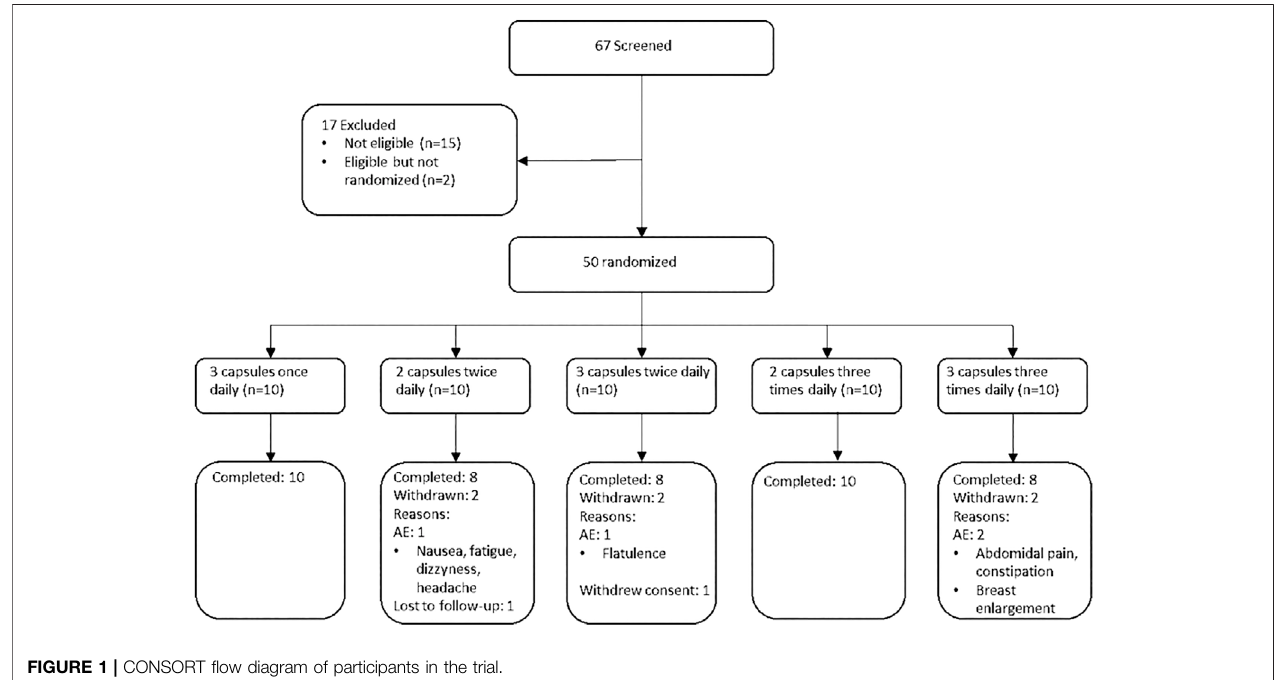
FIGURE 1 | CONSORT fl ow diagram of participants in the trial.